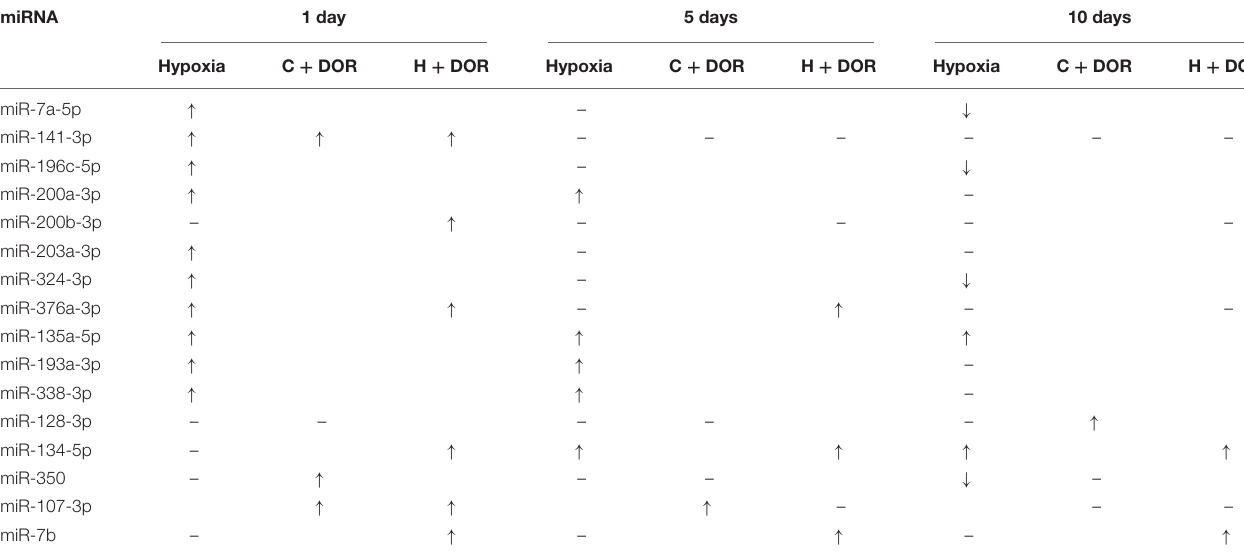
TABLE 8 | Effects of DOR activation on cardiac miRNAs in prolonged hypoxia.